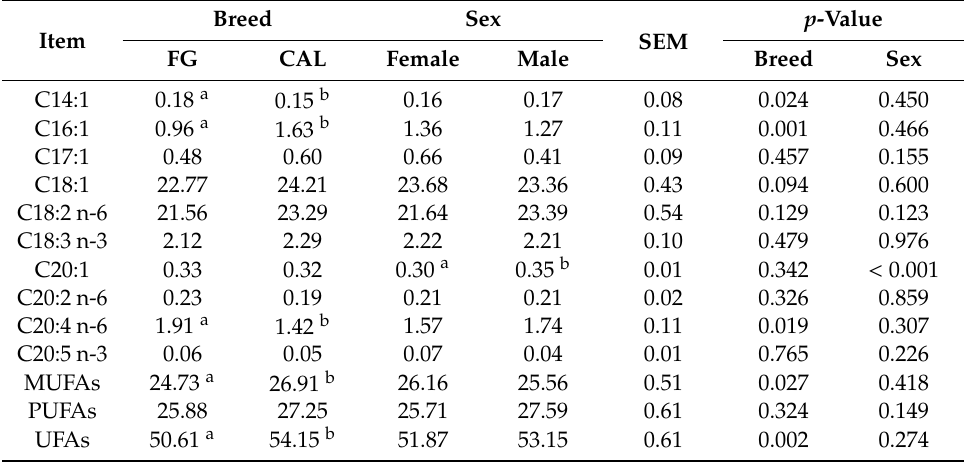
Table 4. Percentages of unsaturated fatty acids in the total fatty acid pool in intramuscular fat ( Longissimus thoracis et lumborum ) in female and male Californian and Flemish Giant Gray rabbits (arithmetic means ± SEM).